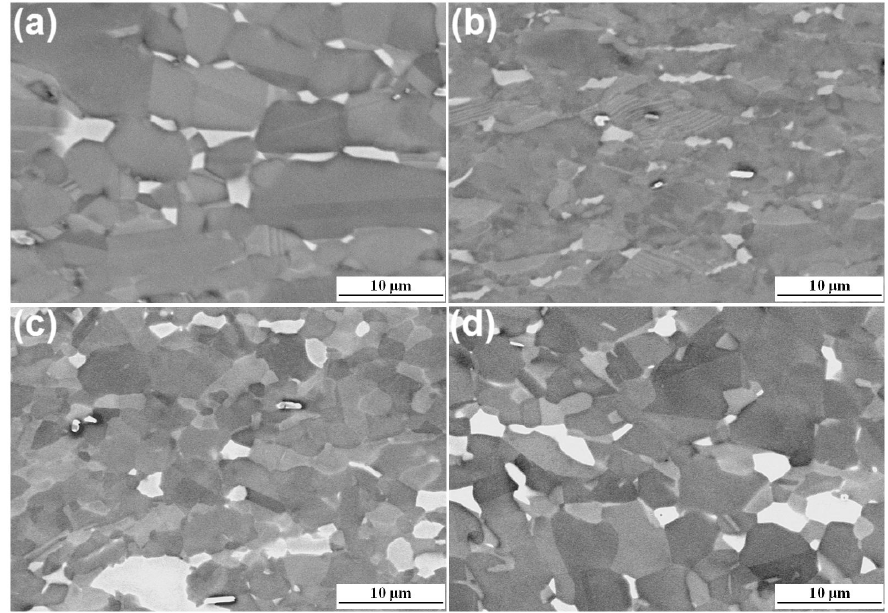
Figure 1. Scanning electron microscope (SEM) images in backscattered electron (BSE) mode of the alloy prior to ( a ) and after compression deformation under 1000 °C with the strain rate of 10 − 2 s − 1 ( b ) and 5 × 10 − 4 s − 1 ( c ) and under 1050 °C with the strain rate of 10 − 4 s − 1 ( d ).